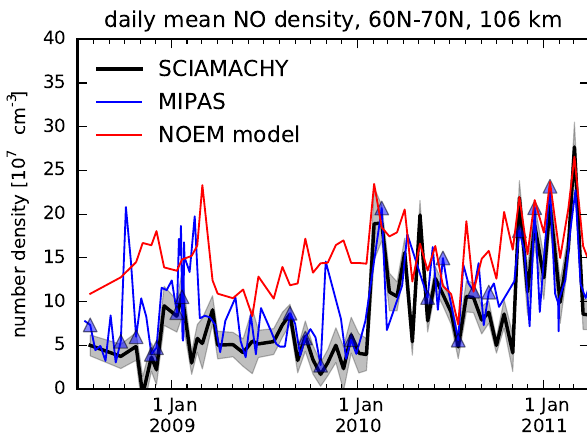
Fig. 12. Ratio of SCIAMACHY to MIPAS NO vertical columns (70–140km), averaged in 20 ◦ latitude bins from 73 coincident or- bits in 2009. The horizontal bars indicate the bins and the vertical bars the 3 σ confidence interval.